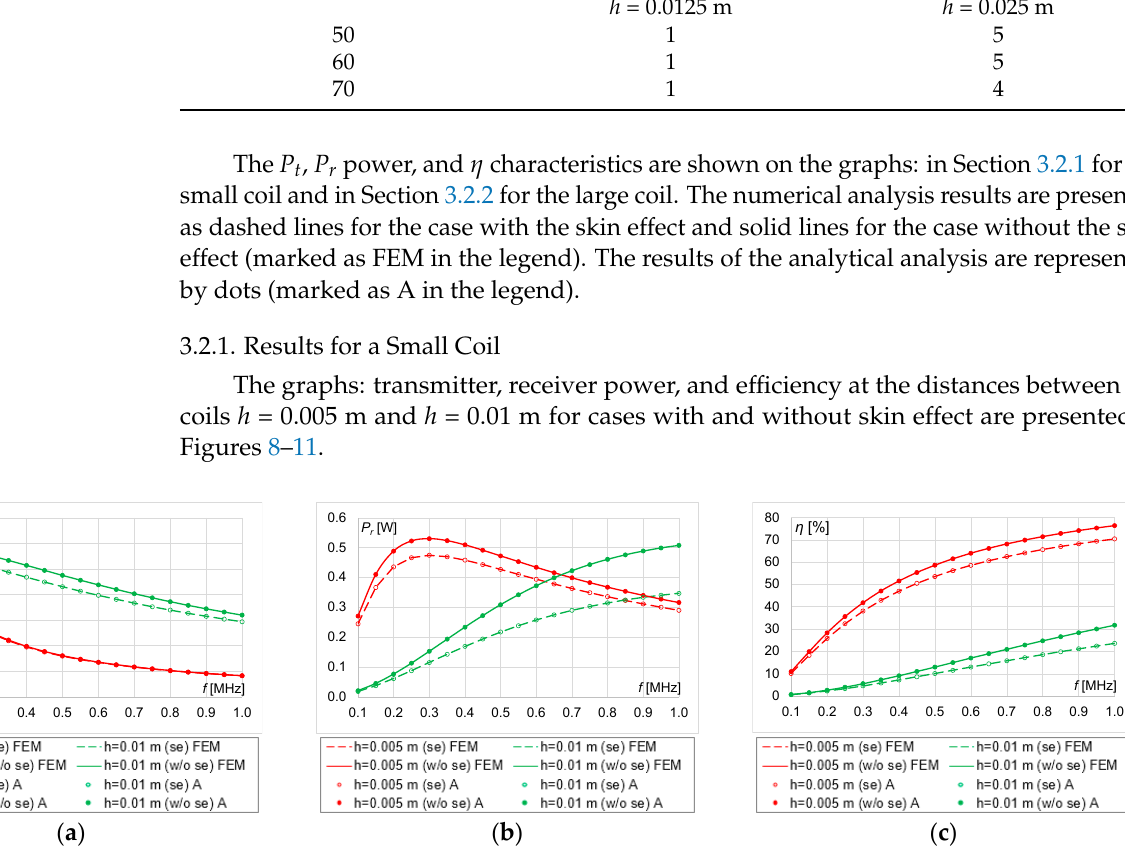
Figure 8. Results for n = 10 for the cases with and without skin effect: ( a ) P t , ( b ) P r , ( c ) η .